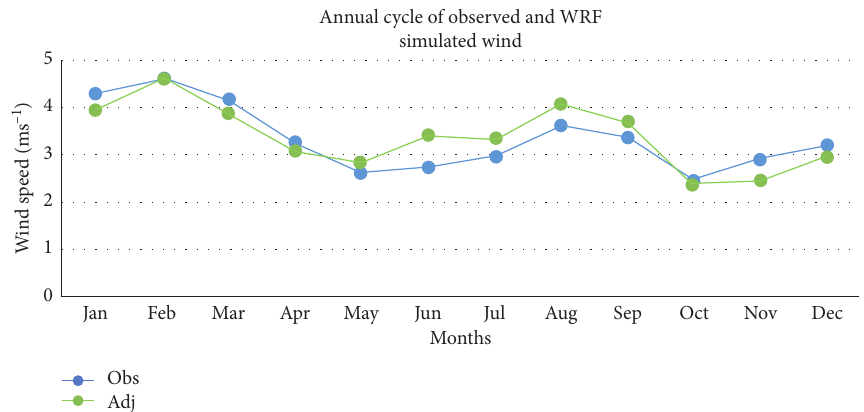
Figure 11: Monthly mean of wind speed at 20m level at Bac Lieu station for observations (blue) and simulated